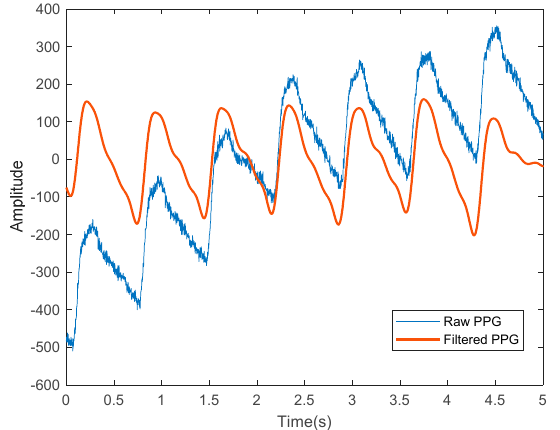
Figure 3. A representation of the PPG signals, where the blue line represents the raw PPG signal before denoising and the red line shows the filtered PPG signals that are ready for further analyses.